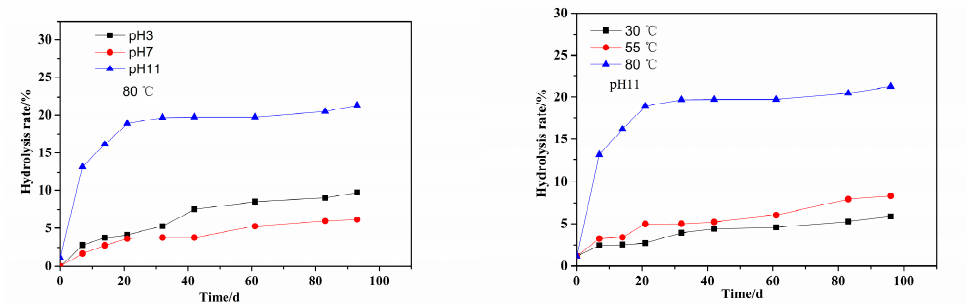
Figure 8. Effects of pH and T on hydrolysis rate of PMAPTAC solution.